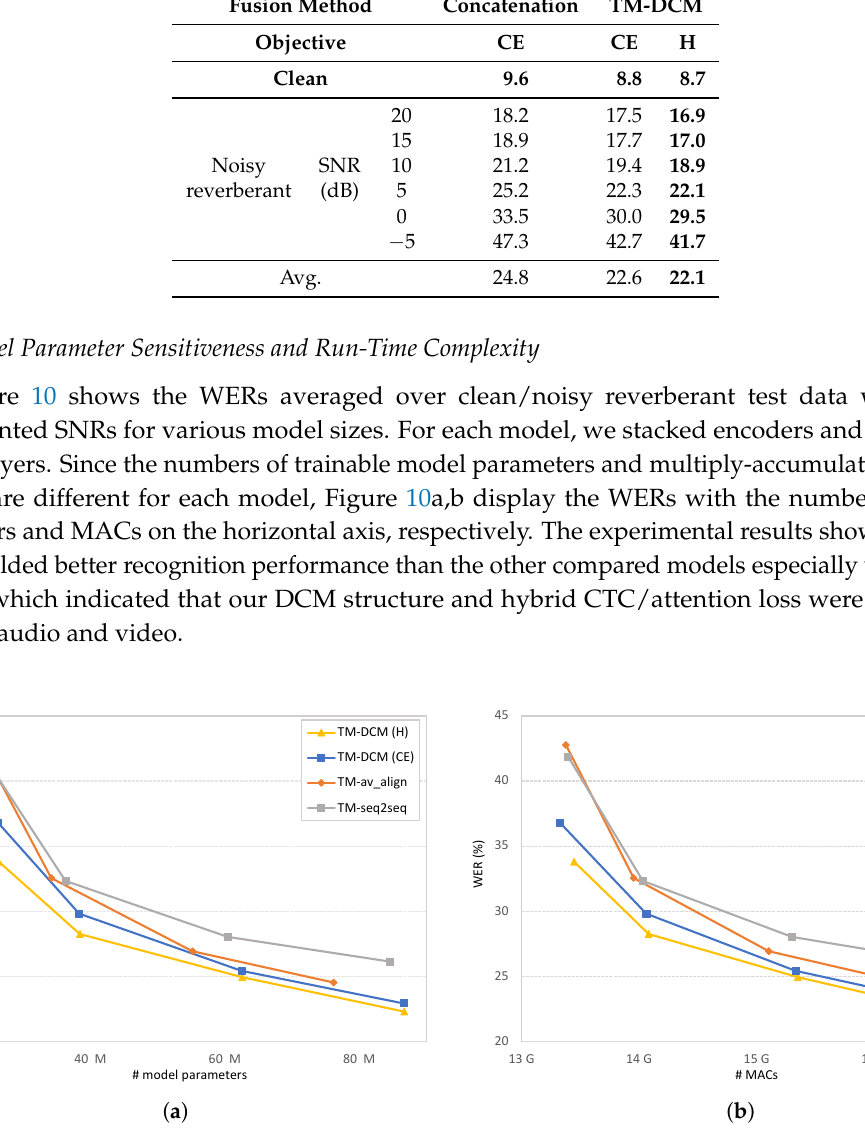
Figure 10. WERs for various model sizes with the numbers of ( a ) trainable model parameters and ( b ) multiply-accumulate operations (MACs). The data used to measure the MACs were “PSlBlZ3hqKc/00011.mp4” in the test set of the LRS3-TED